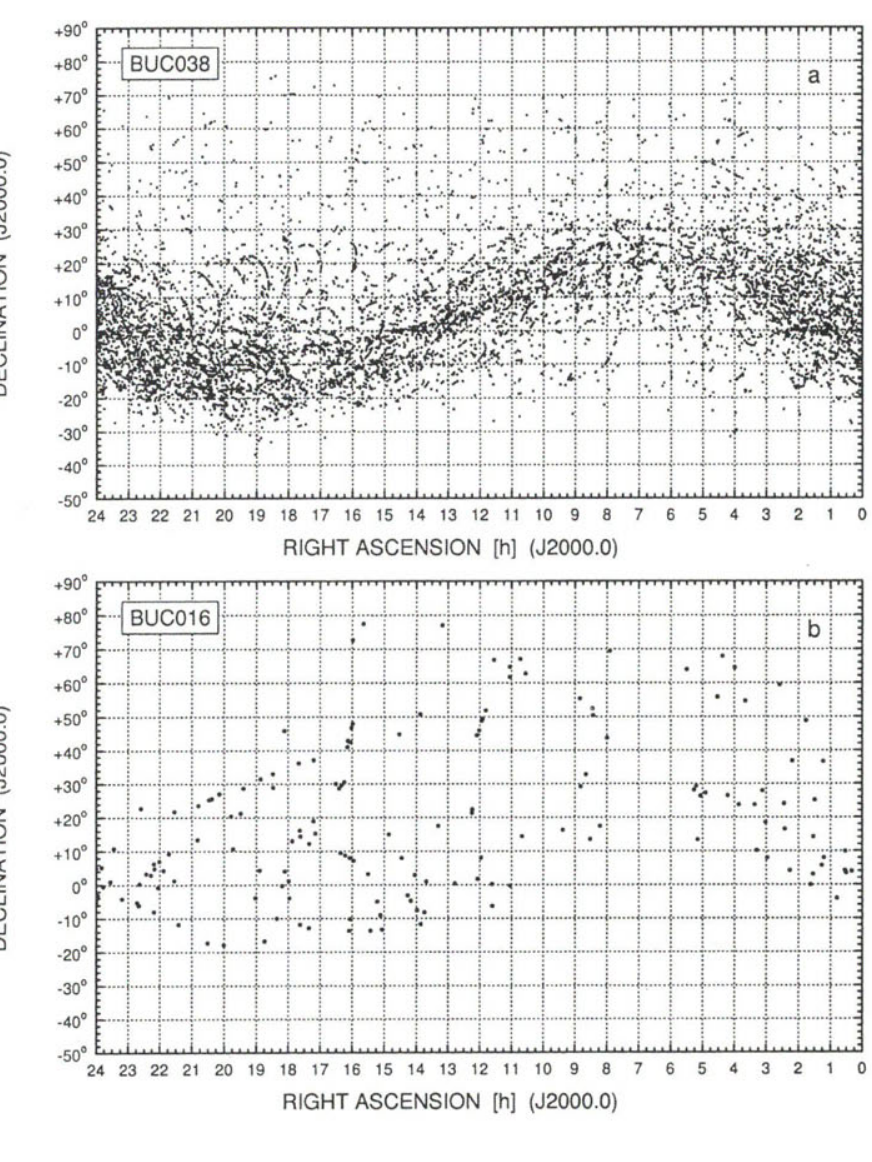
Fig. 1. Distribution on the celestial sphere of the centers of the Bucharest Observatory plates taken with (a) the 0.38 m refractor (BUC038) and (b) the 0.16 m camera